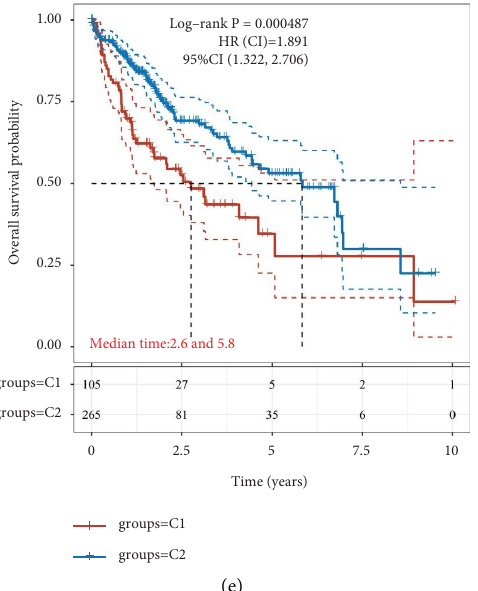
Figure 3: (a) Typed CDF curve of hepatocellular carcinoma cohort. (b) Typed CDF Delta area curve of hepatocellular carcinoma cohort. (c) Plot of PCA results after batch removal. (d) Heatmap of ConsensusClusterPlus consistent clustering results when k � 2. (e) Diferent subgroup samples in the data set are represented by KM survival curves, in which log rank is used to test for diferent groups, and 95% CL represents the HR confdence interval for each